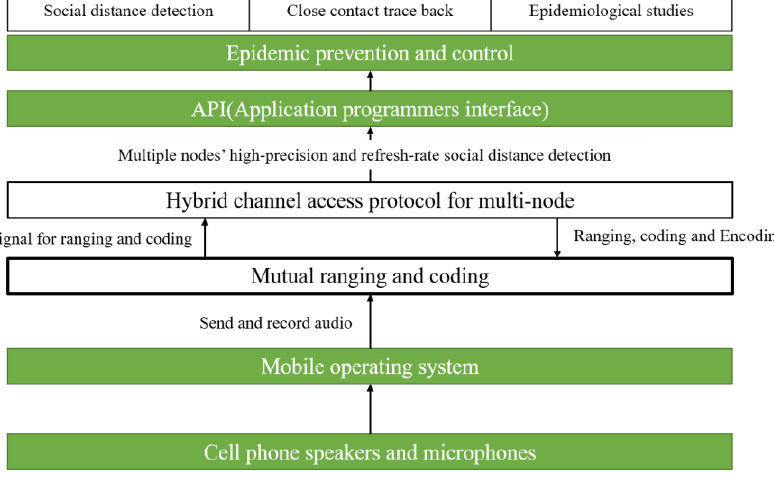
Figure 2. System architecture of system proposed.